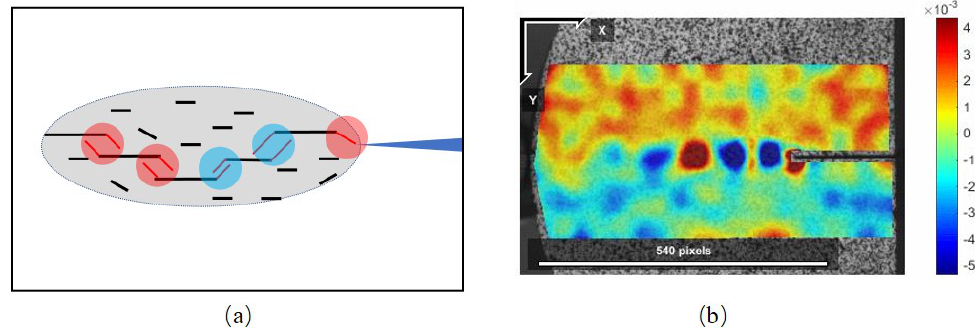
Figure 20. The schematic diagram of the origin of the high shear strain with beaded distribution: ( a ) the micro − cracks in the process zone are connected to each other to form a high shear strain area; ( b ) the high shear strain area with a beaded distribution.